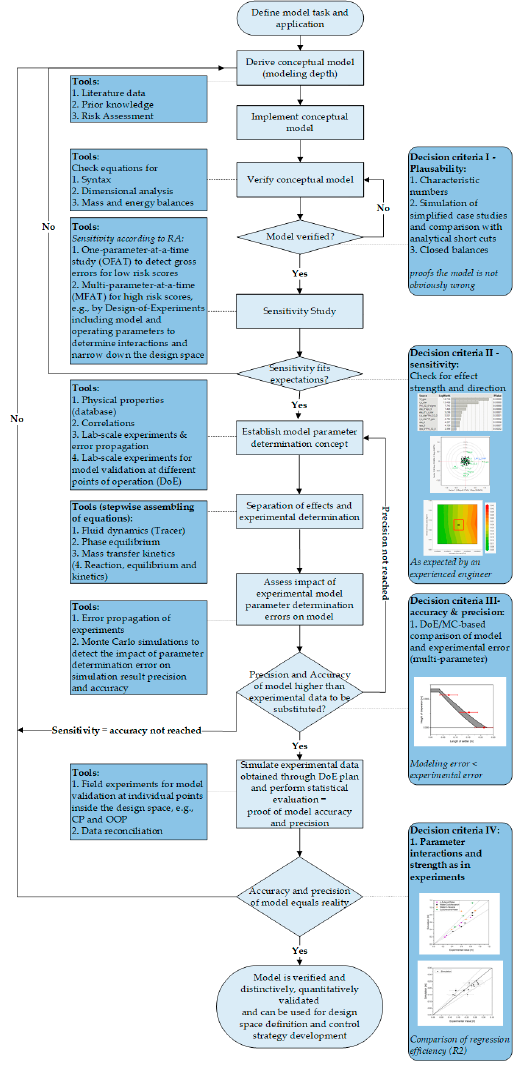
Figure 13. Schematic representation of the model validation workflow [55].